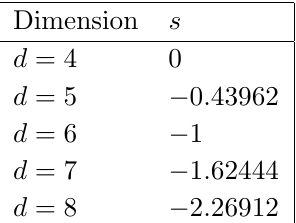
Table 1 . Behaviour of metric function near origin. Here we display several values of s where f ( r ) (cid:24) b r s as r ! 0 and f ( r ) represents a black hole solution. In the cases of (cid:12)ve, seven, and 0